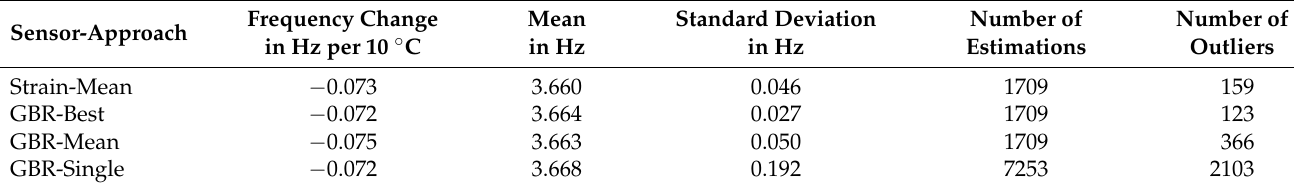
Table 3. Comparison of natural frequency estimation for GBR and strain